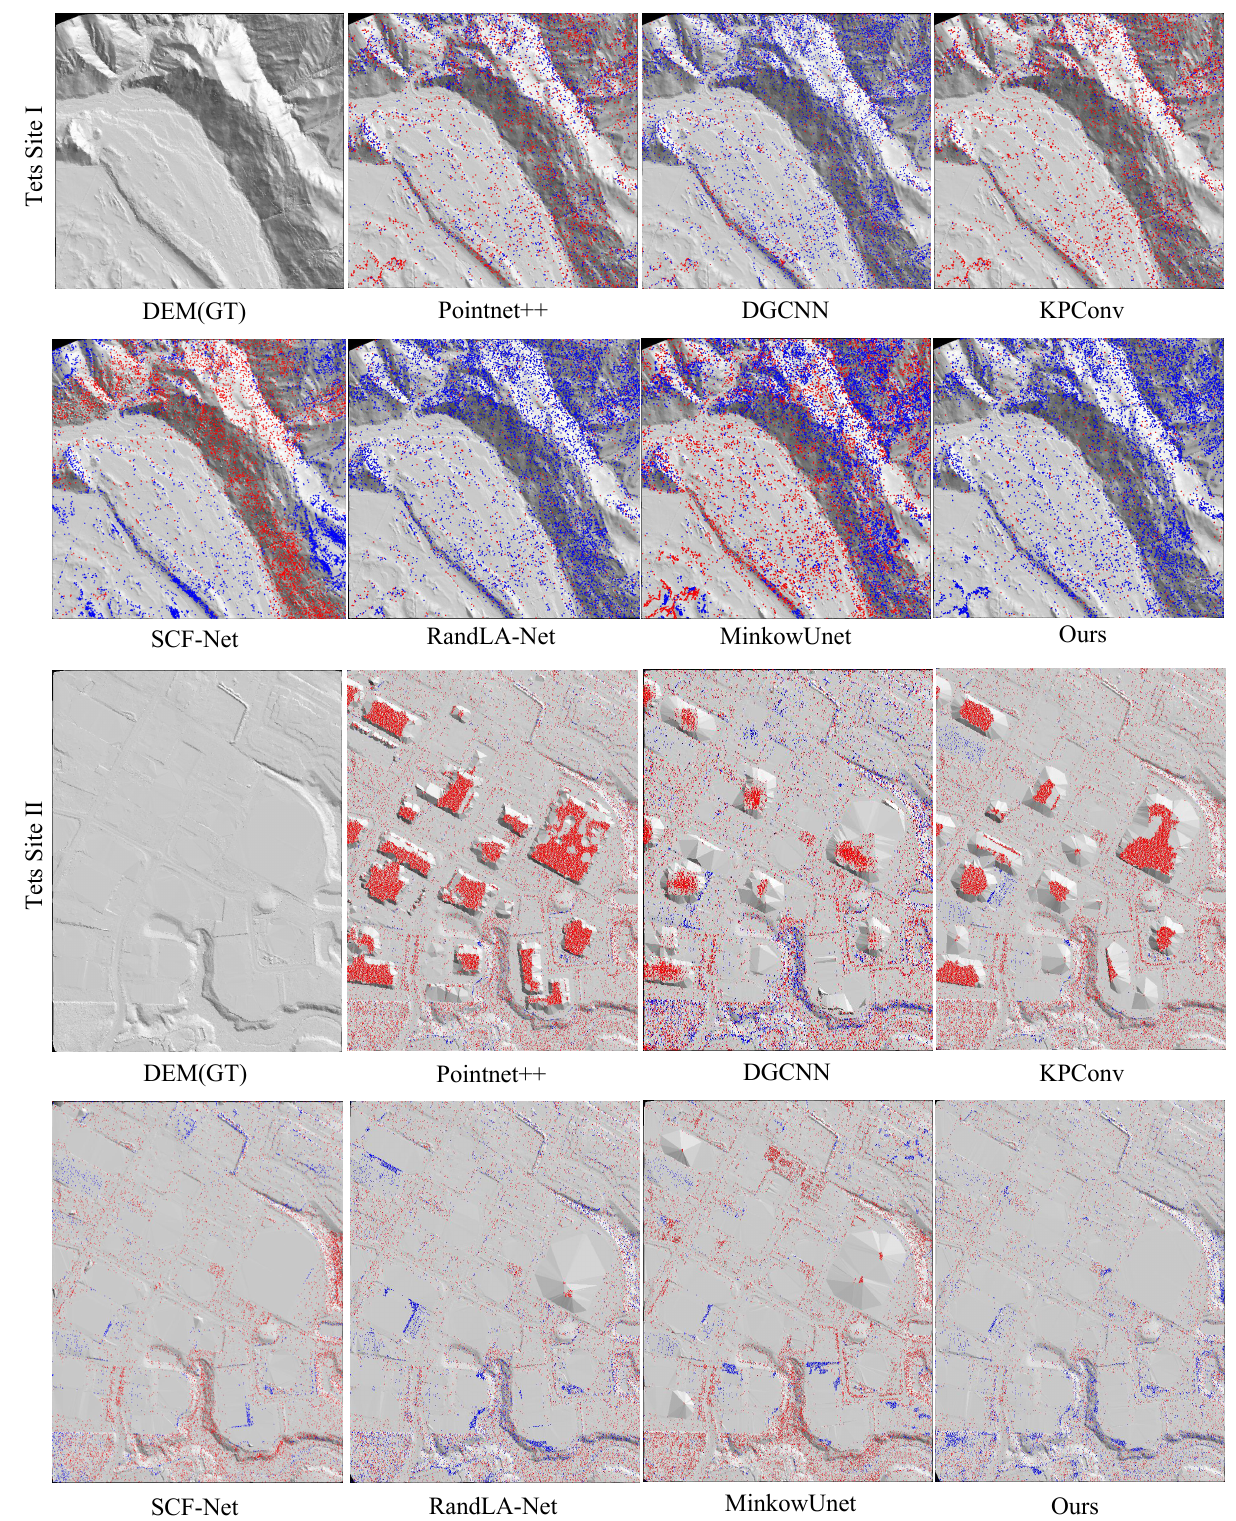
Figure 8. Comparison with the baseline methods of the dataset; Points in red/blue denote the misclassified non-ground/ground points, respectively; Results of these baseline methods are provided along with the OpenGF project